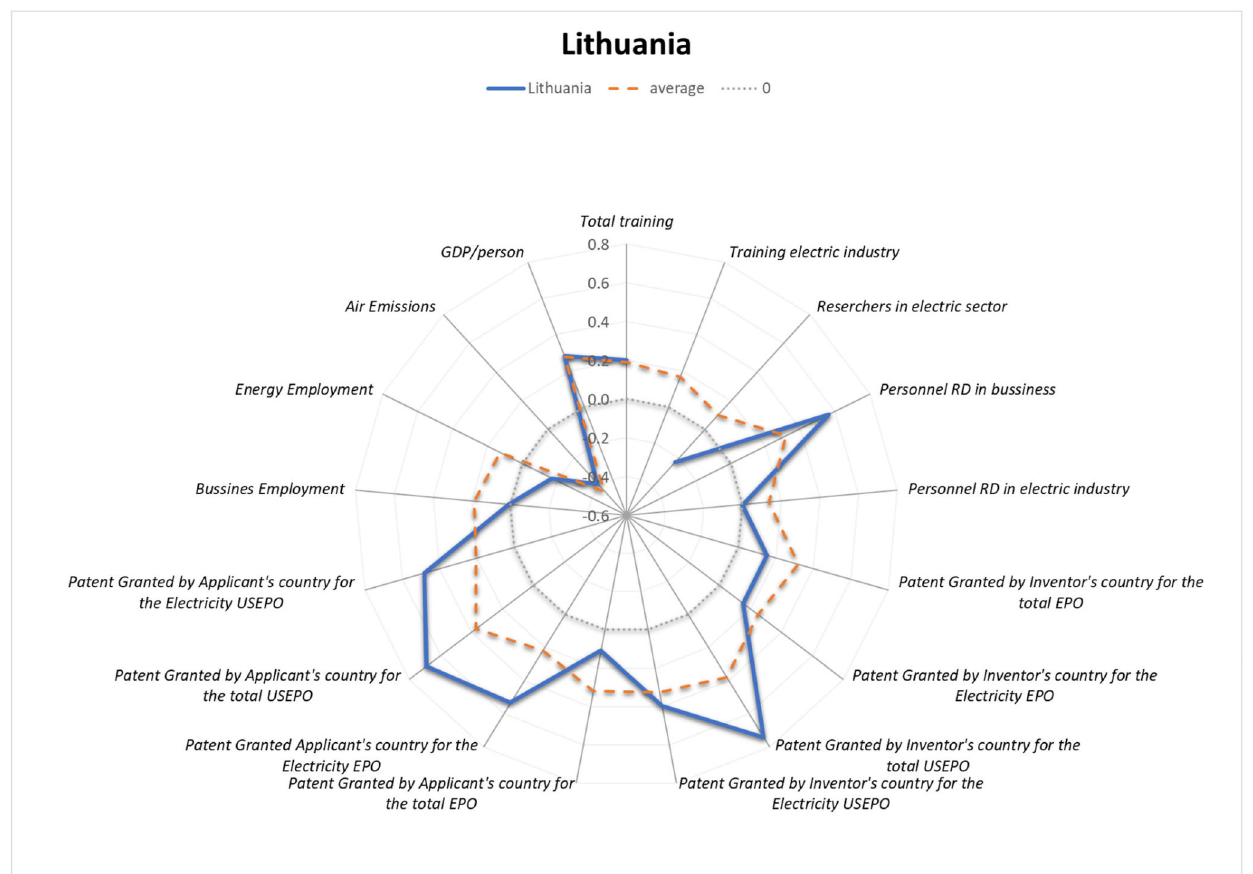
Figure 25. Synergy and trade-off occurrence—LT. Source: Authors’